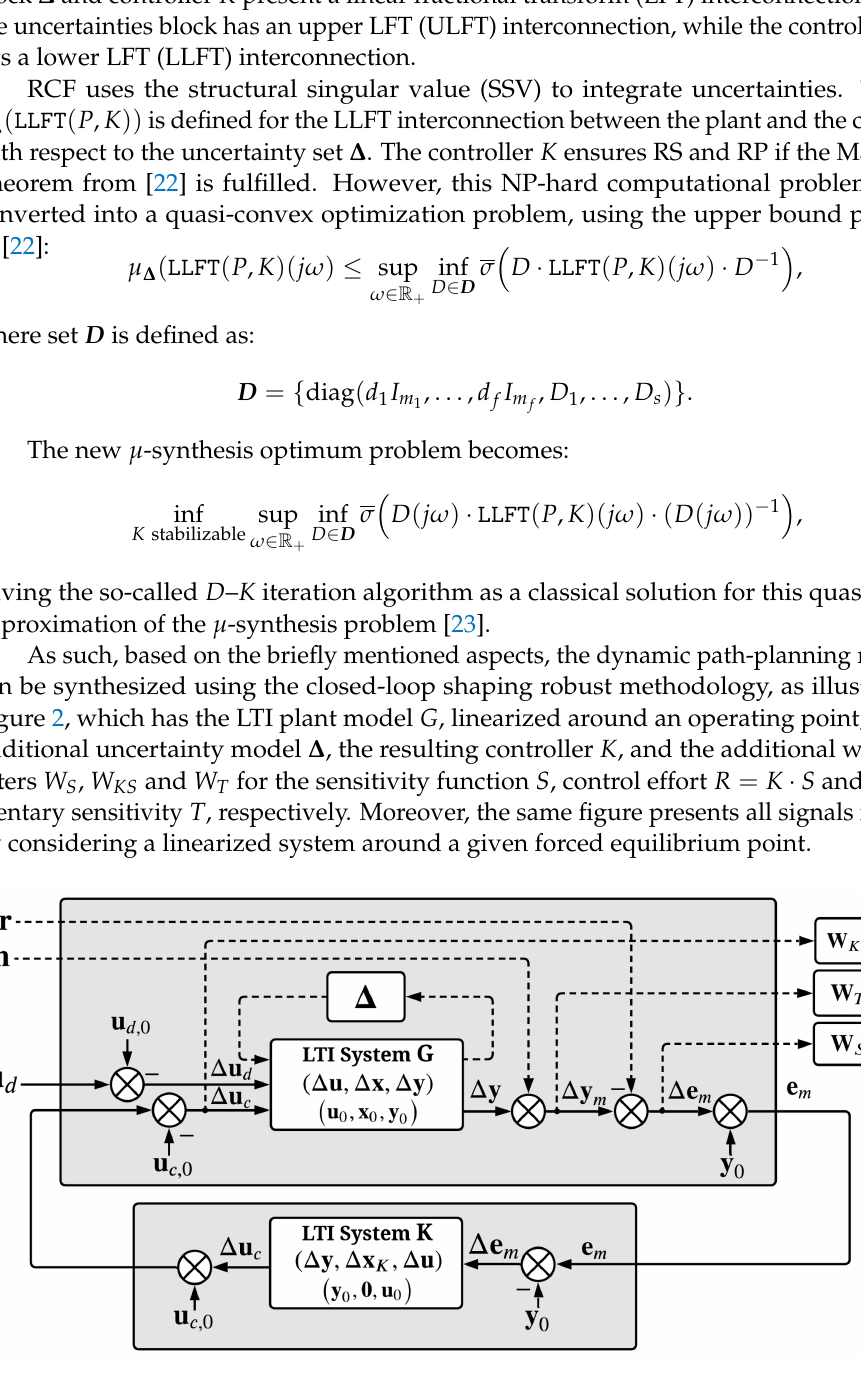
Figure 2. Path-planning regulator design methodology using the closed-loop shaping robust control framework, which can impose the desired bandwidth compared to the K-PBC from Figure 1